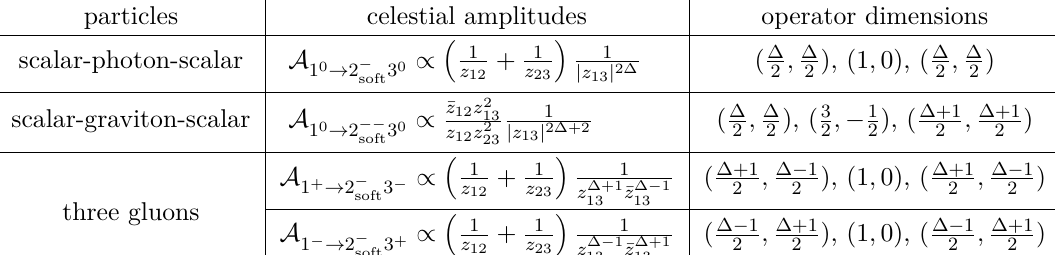
Table 1 . The celestial amplitudes of two massless scalars with a photon or a graviton, and the three-point celestial gluon amplitudes. The logarithmic conformal primary wave functions were used for the soft (second) particles. The conformal dimensions of the corresponding CCFT operators are given in the last